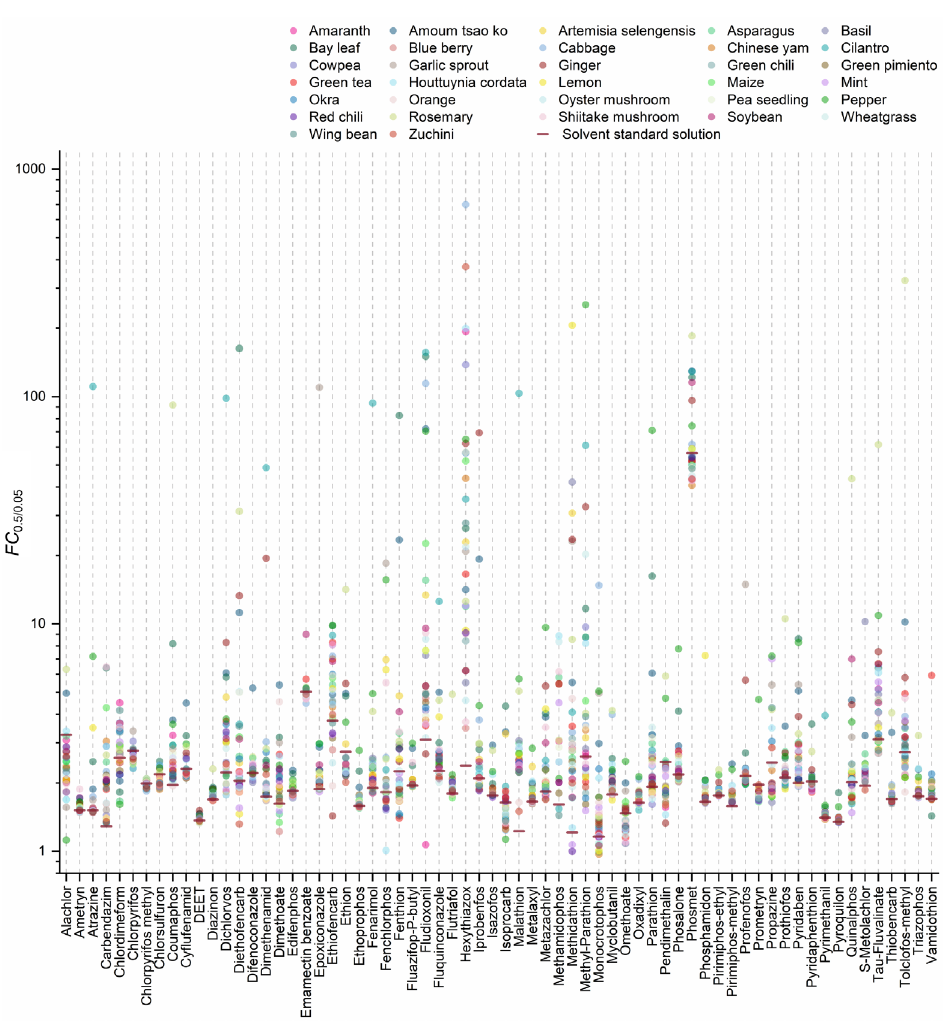
Figure 7. Distribution of FC 0.5/0.05 for 62 pesticides among 32 matrix species.